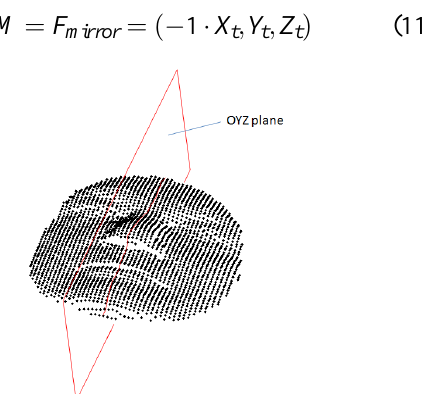
Fig. 9. Human face is a symmetric surface about OYZ plane.